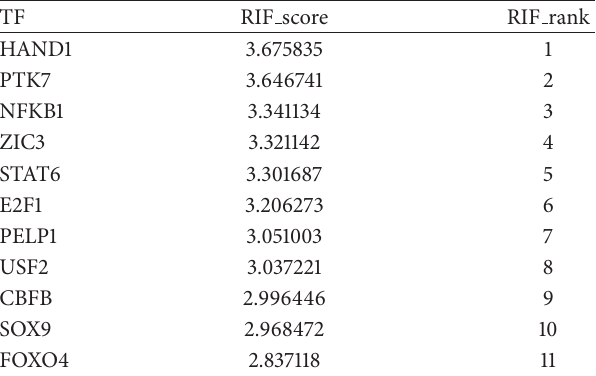
Table 2: Top 10 TFs in differentially regulatory network.